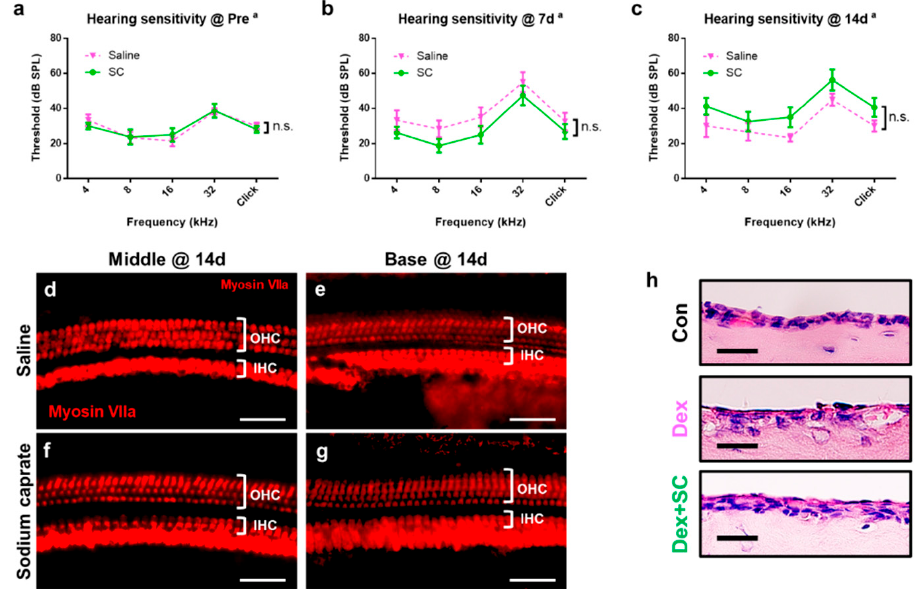
Figure 4. Sodium caprate displaying no sign of ototoxicity. ( a – c ) Auditory sensitivity was evaluated by the auditory brainstem response (ABR) in saline- or sodium caprate-treated rats at pre- (baseline, A) and post-treatment (7 and 14 d, b , c ). Thresholds from ABR were recorded and graphed. No significant differences were found between groups treated with saline (pink line) and sodium caprate (green line) at all time points. Graphs represent mean ± SEM. Two-way repeated measures ANOVA; Sidak’s multiple comparisons test; a, main effect of frequency; n.s., not significant; n = 6 (saline); n = 8 (sodium caprate). ( d – g ) Sodium caprate does not alter cochlear hair cells. Microdissected cochlear tissues were immunofluorescently stained for myosin-VIIa and imaged using epifluorescence. Representative images were shown from the cochlear middle and basal turns to show the hair cell densities for the three rows of OHC and single row of IHC for the saline-treated control ( d , e ) and that treated with sodium caprate ( f , g ). No significant differences were observed between the saline- and sodium caprate-treated groups at 14 d from both the middle and basal turns. Scale bar = 100 µ m. ( h ) Dex + SC-treated mucosa presents healthier lining and morphology as compared to the dex-only group, indicating SC induces no sign of damage at 14 d post-treatment. Scale bar = 15 µ m.